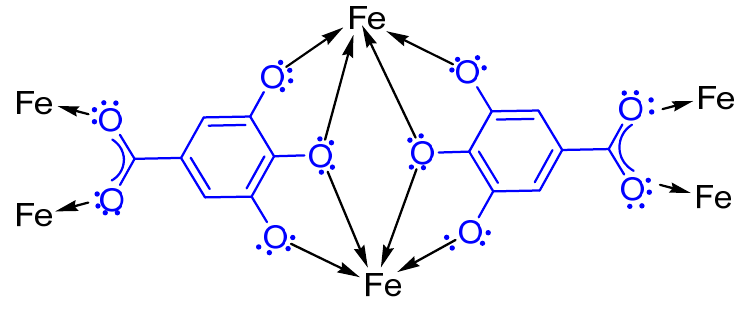
Figure 5. Proposed structure of iron